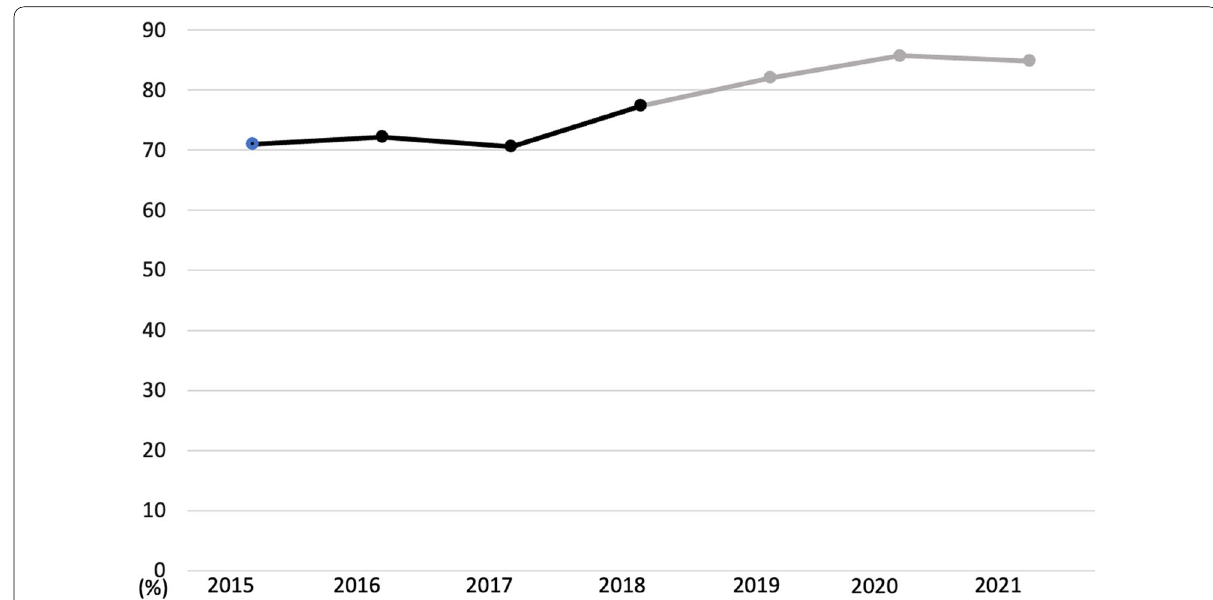
Fig. 4 Bar graph of the success rate of miniscrews from 2015 to 2021 in the graduate clinic (dark line: before the training, gray line: after the